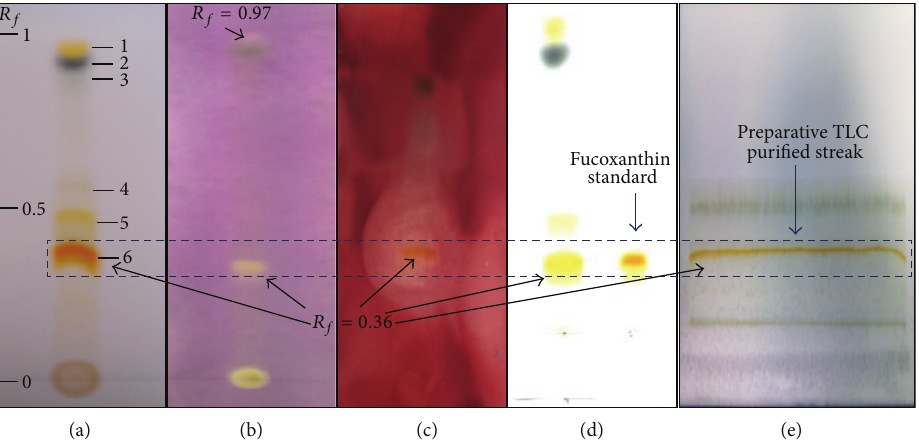
Figure 1: TLC based detection of compounds of H. elongata seaweed, visualized under visible light (a), bio-autographic screening of active antioxidant compound stained with 2.54 mM DPPH ∙ solution in methanol (b), bio-autographic screening of active antimicrobial compound stained with 2% aqueous TTC solution (c), identification of active compound with respect to fucoxanthin standard (d), and purification of active compound using preparative-TLC (e).